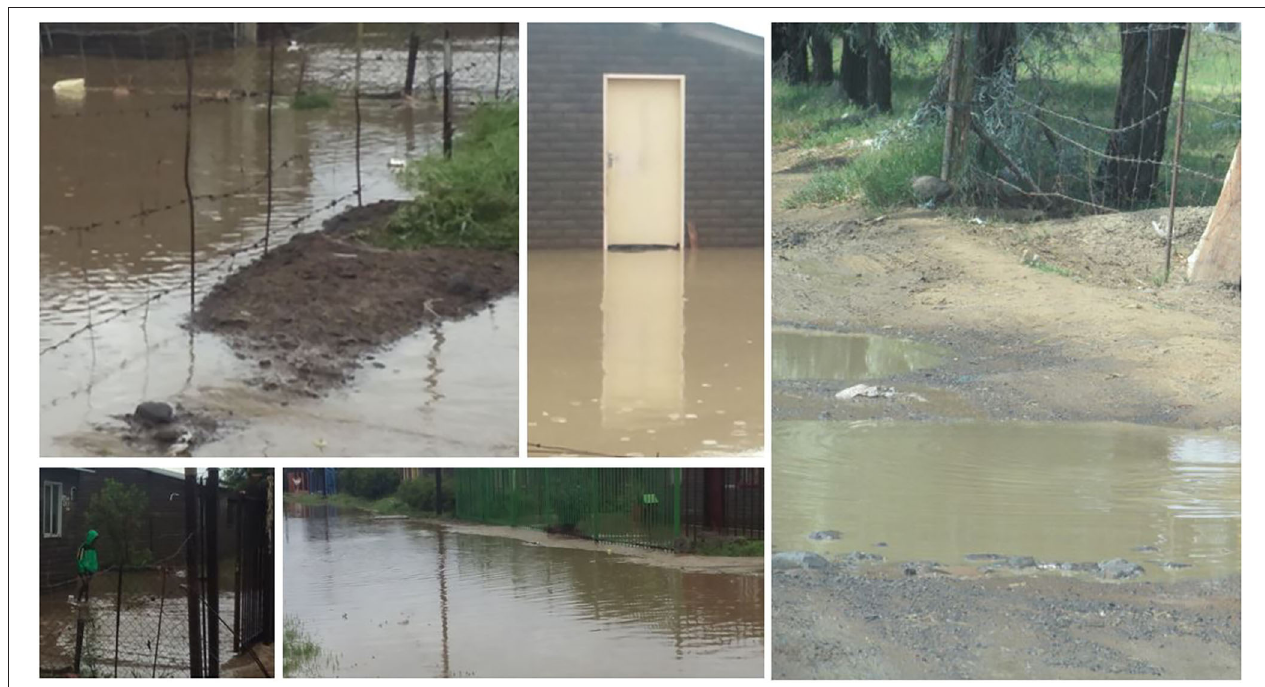
FIGURE 2 | Hailstorm and human excreta in low-income communities of Mangaung.